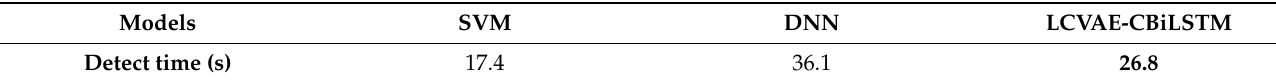
Table 6. Detection time of different